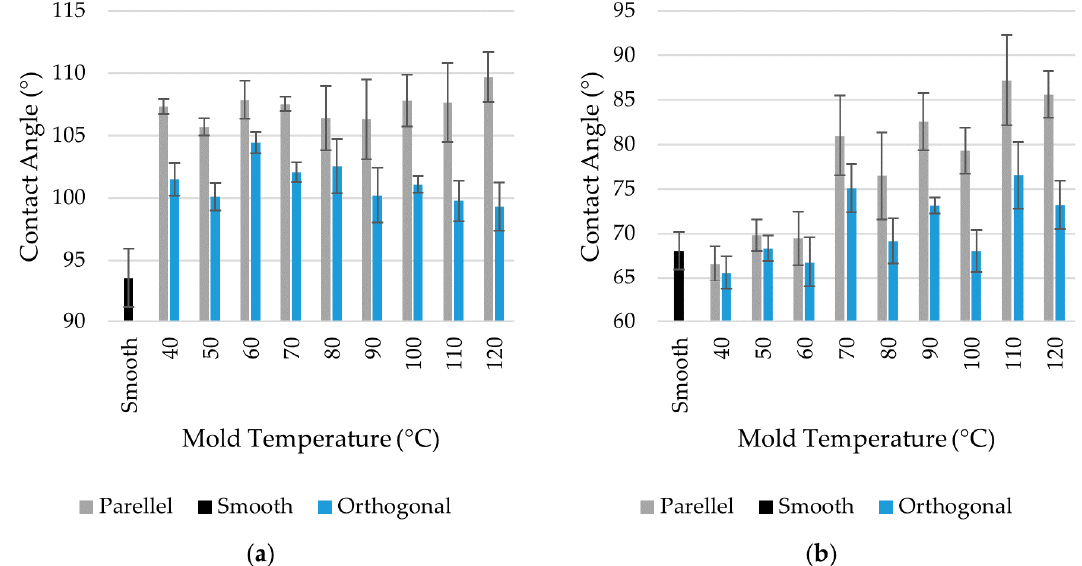
11 of 15 Figure 8. ( a ) Replicated structure heights for PMMA and PS. ( b ) Zero shear viscosity dependence on temperature for PMMA and PS. 3.3. Plastic Parts Surface Wettability The analysis of the contact angles indicates that the wetting properties of plastic parts were affected by the replicated sub-micron structures. Due to the anisotropy of the textured surface, the drop has an ellipsoidal shape. To account for this effect, the contact angle along two directions (see Figure 4) was measured. The results reported in Figure 9 show that the parallel angle assumed higher values than the perpendicular one, indicating that water drops spread easier along the ripples. The